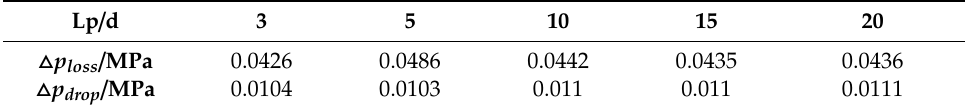
Table 6. Influence of non-equidistant channels for configuration “A”.